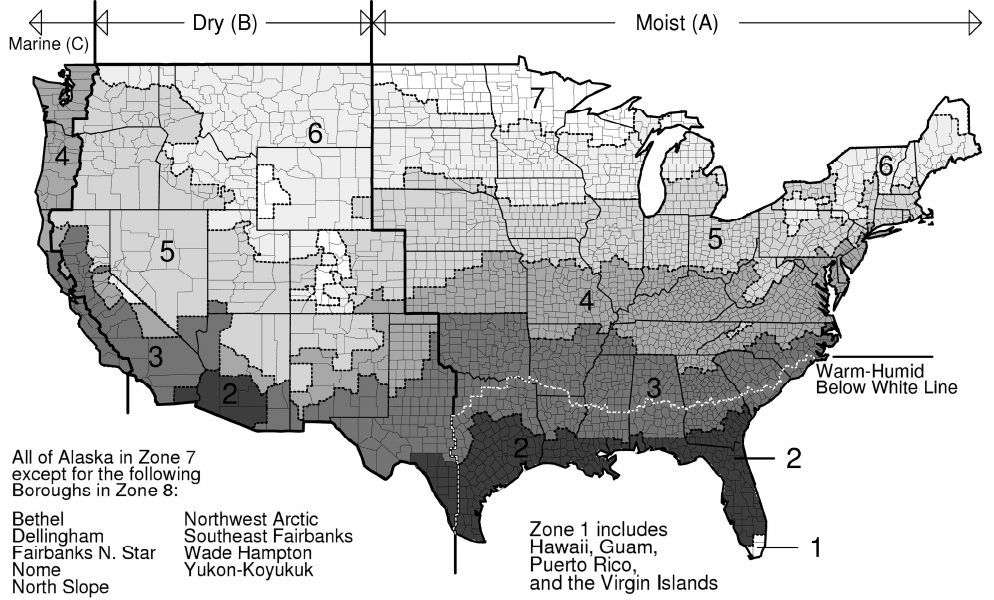
Figure 9. Severity and frequency of extreme weather conditions [21]. (Climate Zone Map, excerpted